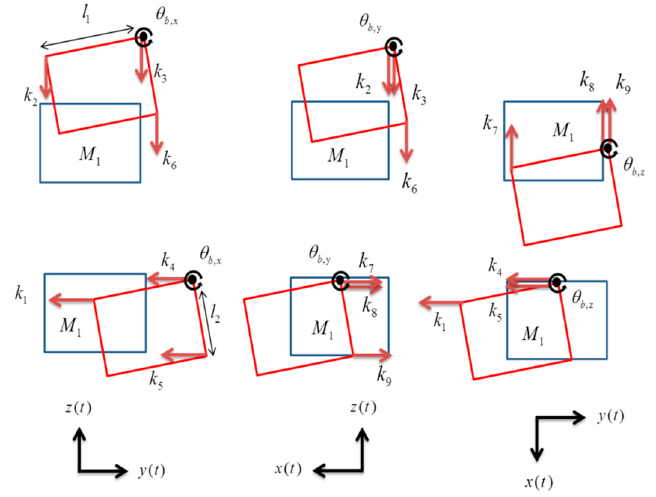
Figure 2. Free-body diagrams of the main projection unit.